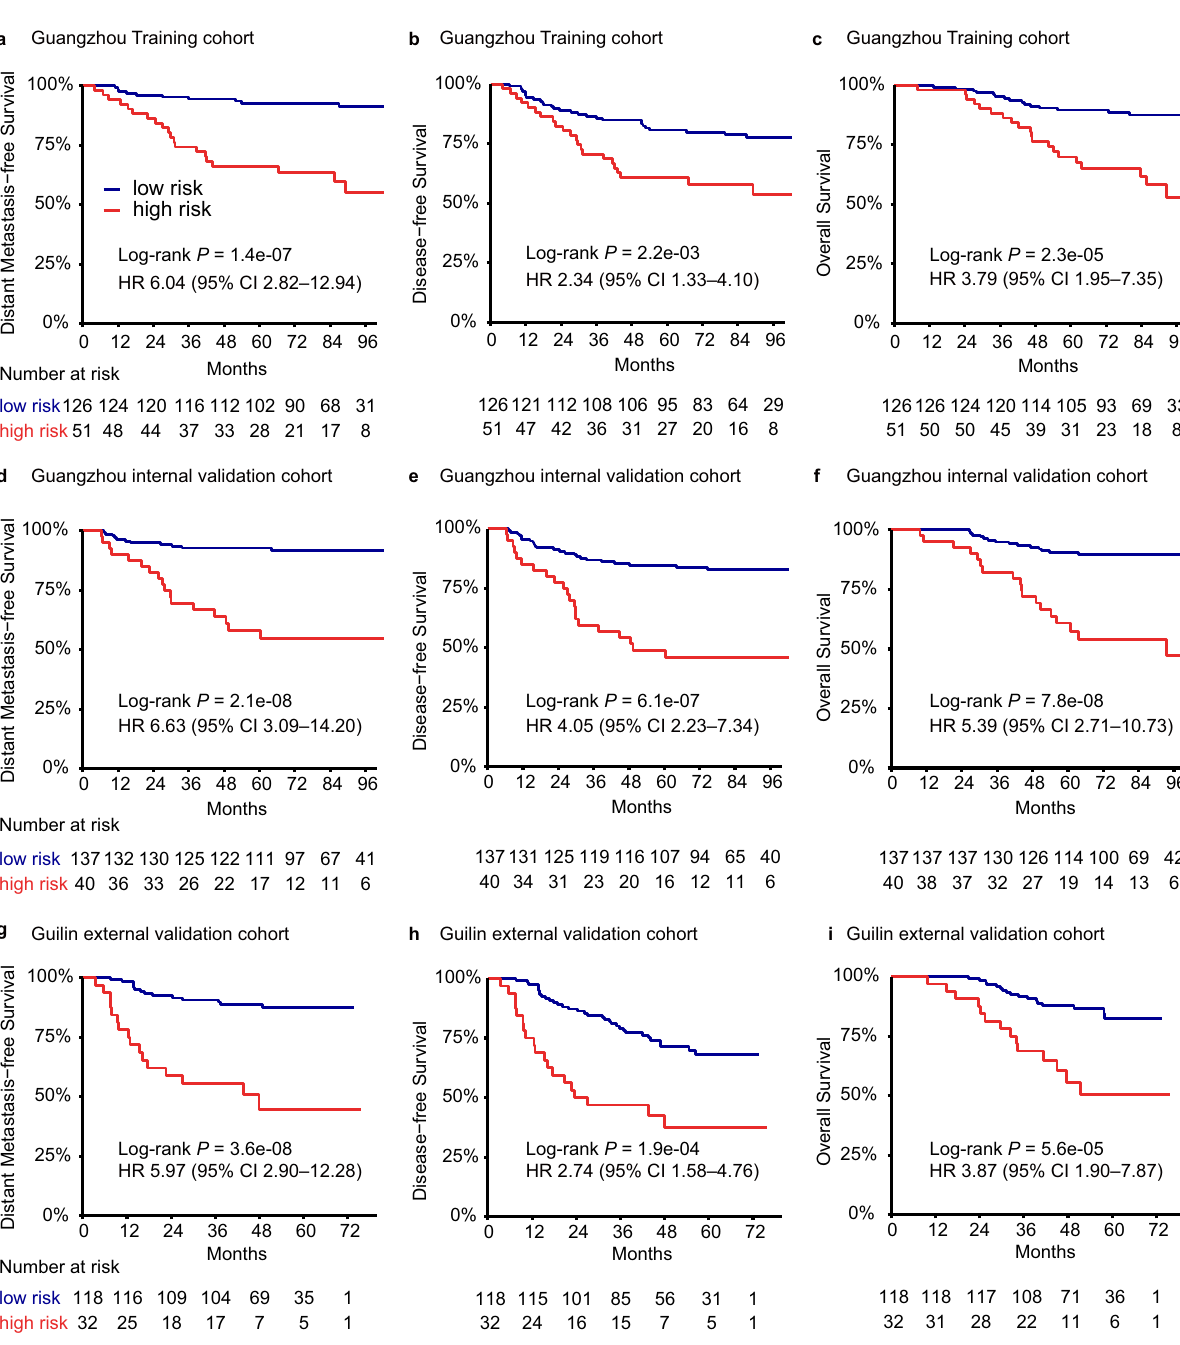
Fig. 2 Kaplan – Meier estimates survival curves for the high-risk and low-risk groups according to the nine-lncRNA signature. a – c Distant metastasis- free survival ( a ), disease-free survival ( b ), and overall survival ( c ) in the training cohort ( n = 177). d – f Distant metastasis-free survival ( d ), disease-free survival ( e ), and overall survival ( f ) in the Guangzhou internal validation cohort ( n = 177). g – i Distant metastasis-free survival ( g ), disease-free survival ( h ), and overall survival ( i ) in the Guilin external validation cohort ( n = 150). The log-rank test was used to calculate P values (two-sided), and univariate Cox regression analyses were used to estimate the hazard ratios. HR hazard ratio, CI con fi dence interval. Source data are provided as a Source Data fi